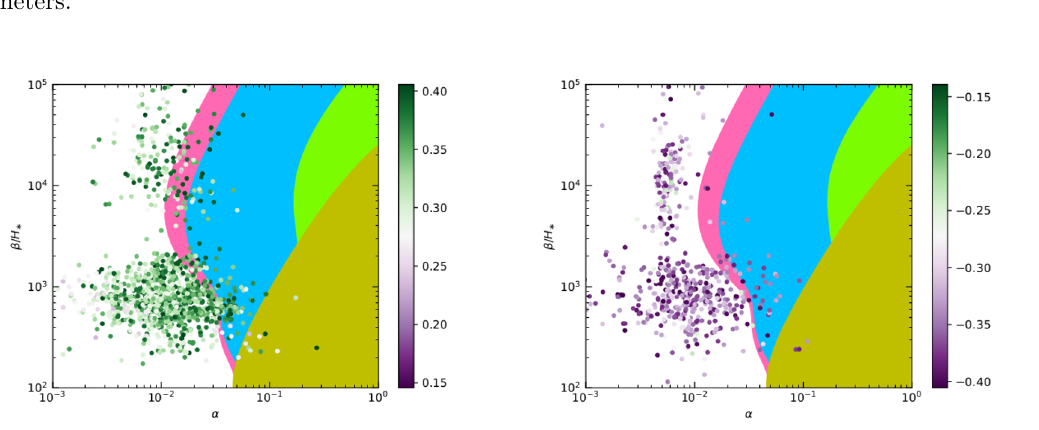
A summary of parameters and assumptions used for the planned space-based interfer- ometers.